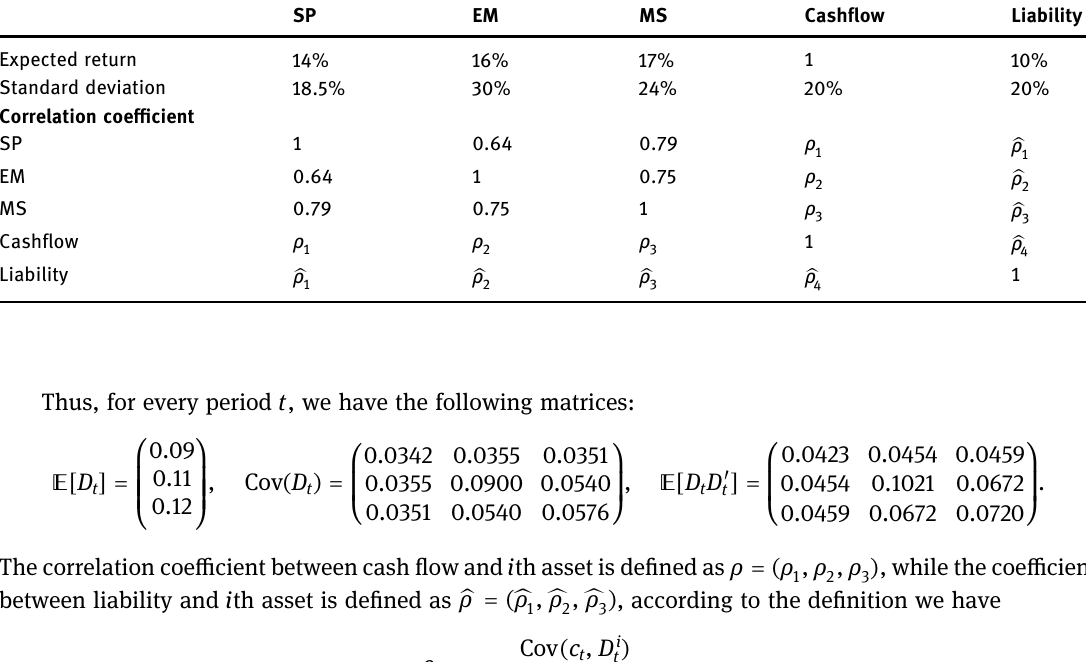
Table 1: Data for assets and cash fl ow SP EM MS Cash fl ow